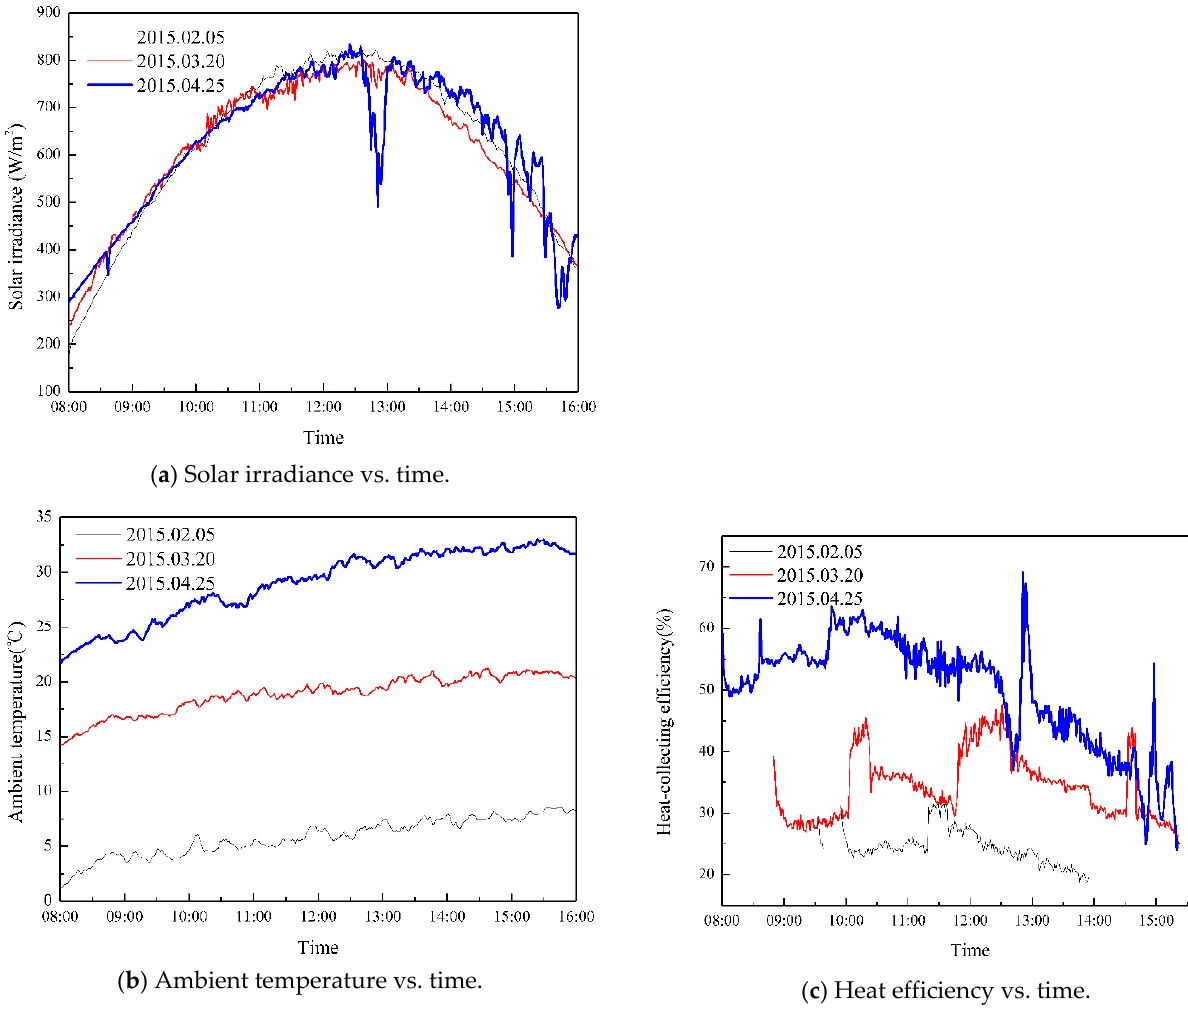
The effect of irradiance on the hot-water system is shown in Figure 3. Performance analysis of the conditions with similar environmental temperature and different irradi- ance were selected. It can be seen that temperature change for the environment had av- erages of 21.10 °C, 21.70 °C, and 20.70 °C, and the difference was small. Figure 3b is the change of irradiance with the average values of 379.20, 677.60, and 287.80 W/m 2 . The differences are obvious. Figure 3c shows the changes in the thermal efficiency of the so- lar hot-water system with operating time. The mean values were 41.42%, 45.44%, and 34.91%, and the collection efficiency and irradiance were positively correlated. The higher the irradiance, the greater the collection efficiency. Given the increased irradi- ance, the relative increase of absorption of solar energy collector, or the set of heat in- crease, the increase in amplitude is greater than its irradiance range. The solar collectors’ collection efficiency calculation Equation (3) shows that when other parameters were constant, the collection efficiency agreed with the irradiance correlation. The higher the irradiance, the greater the collection efficiency. The diagram also implies that the higher the irradiance, the longer its collection of the thermal cycle. The sooner the cycle starts, the shorter the operation time will be. The hot-water system starts early but stops late, which is mainly related to the solar heat collection and the open cycle operation of the heat pump [17].